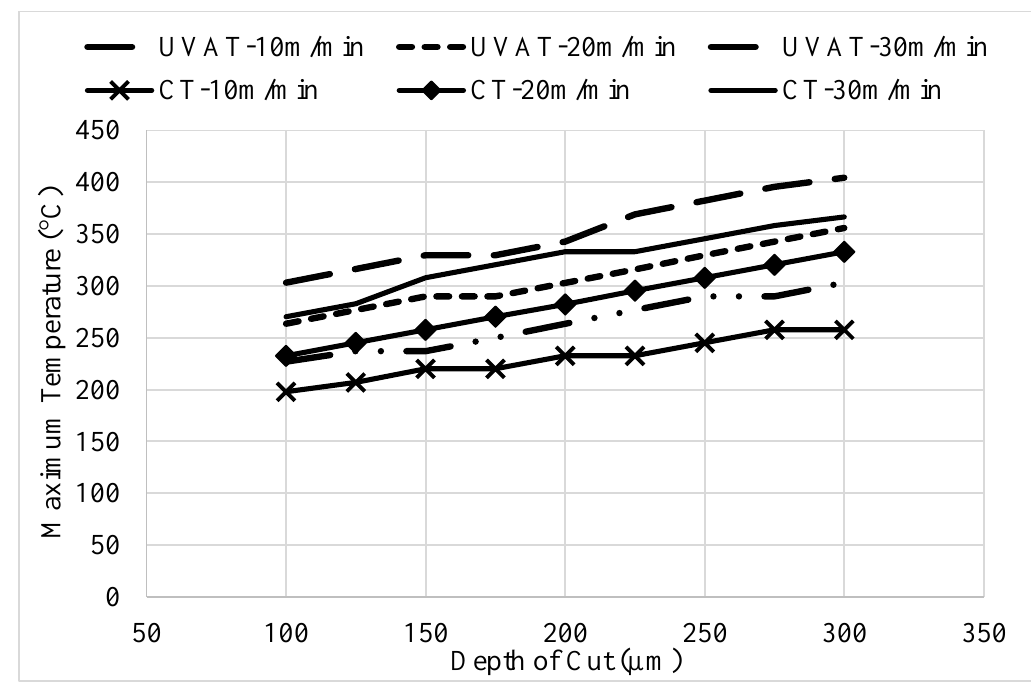
Figure 7. The predicted maximum temperature results in UVAT and CT.